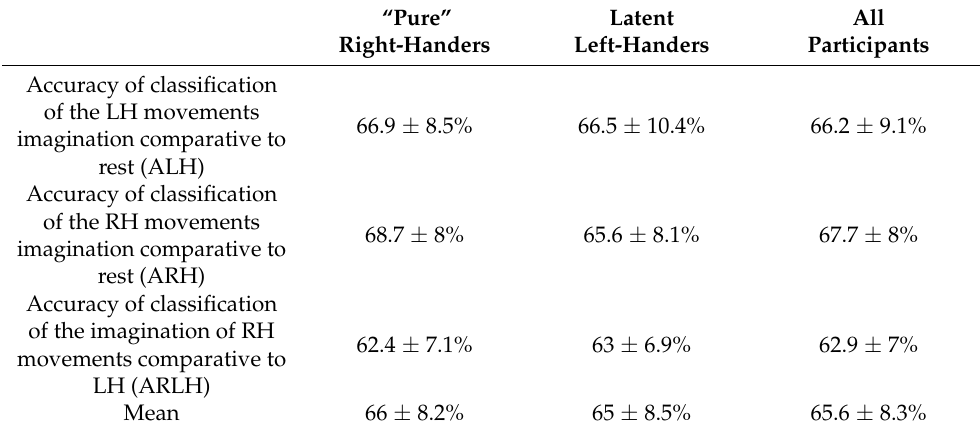
Table 2. The average classification accuracy for latent, “pure” right-handers and all participants together (m ± SD).